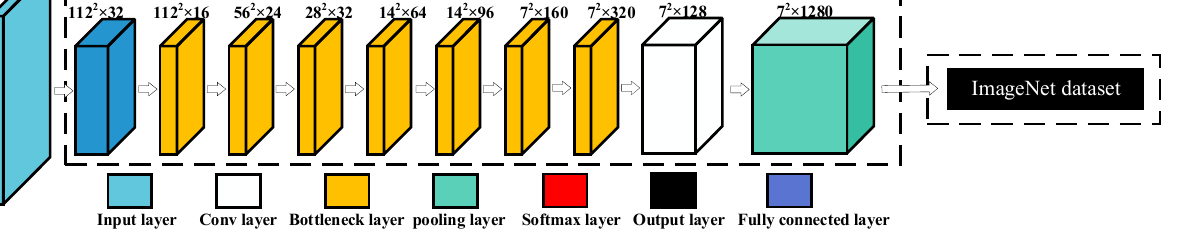
Figure 5. MobileNetV2 original model.